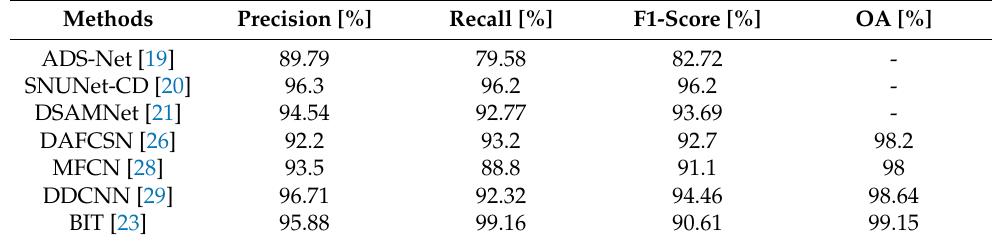
Table 9. Comparative analysis of the SVD dataset.